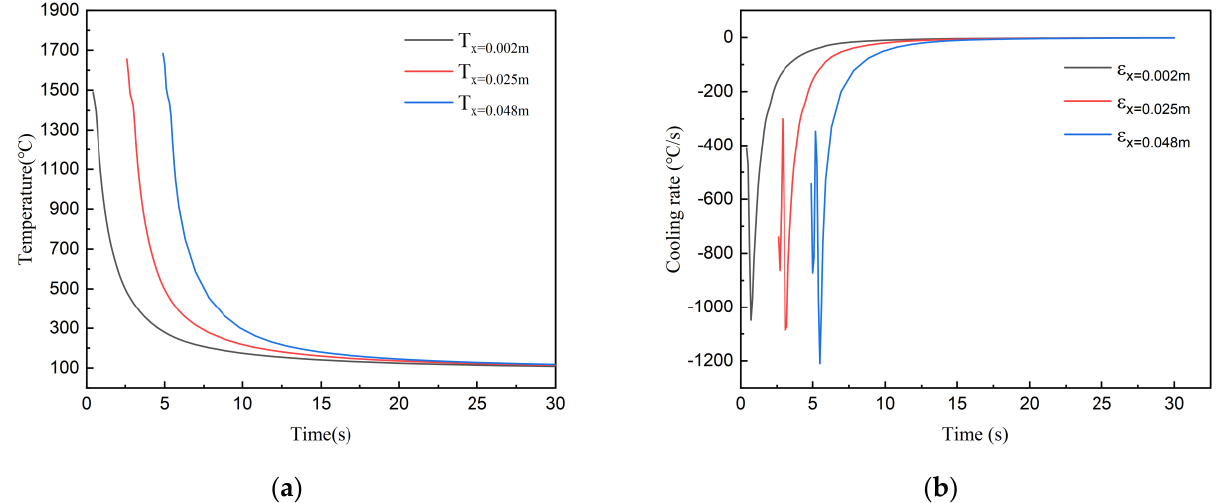
Figure 4. Cooling temperature and rate: ( a ) transient solidification temperature and ( b ) transient cooling rate.